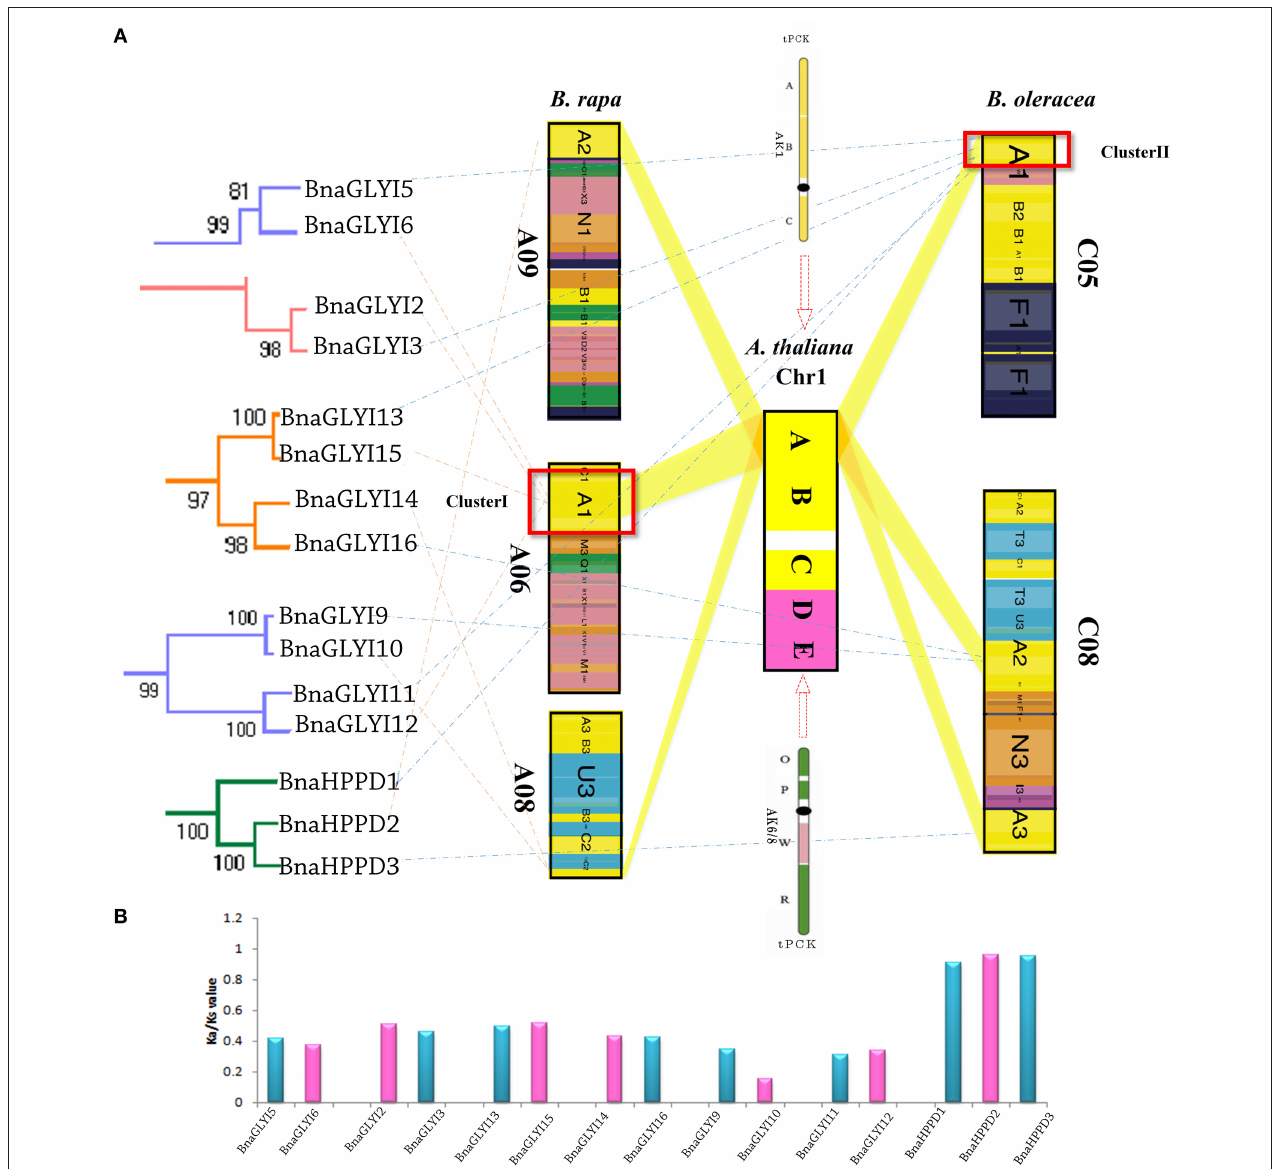
FIGURE 4 | Evolutionary pattern analysis of pair-wised BnaVOC genes. (A) Phylogenetic relationships and evolutionary progress of the VOC genes in Brassica evolution. (B) Ka/Ks value comparison of the pair-wised BnaVOC